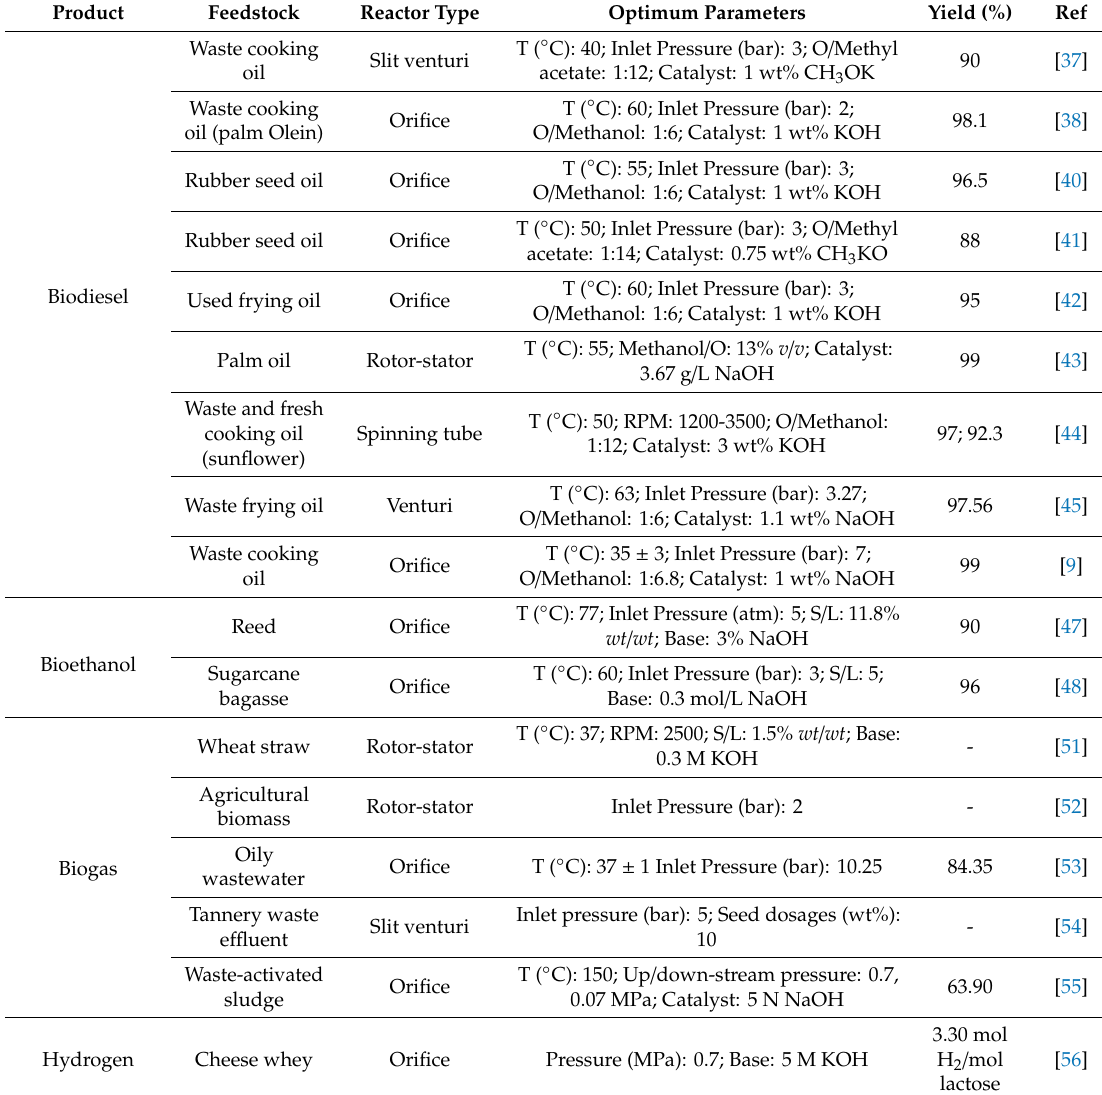
Table 4. HC-mediated biofuel